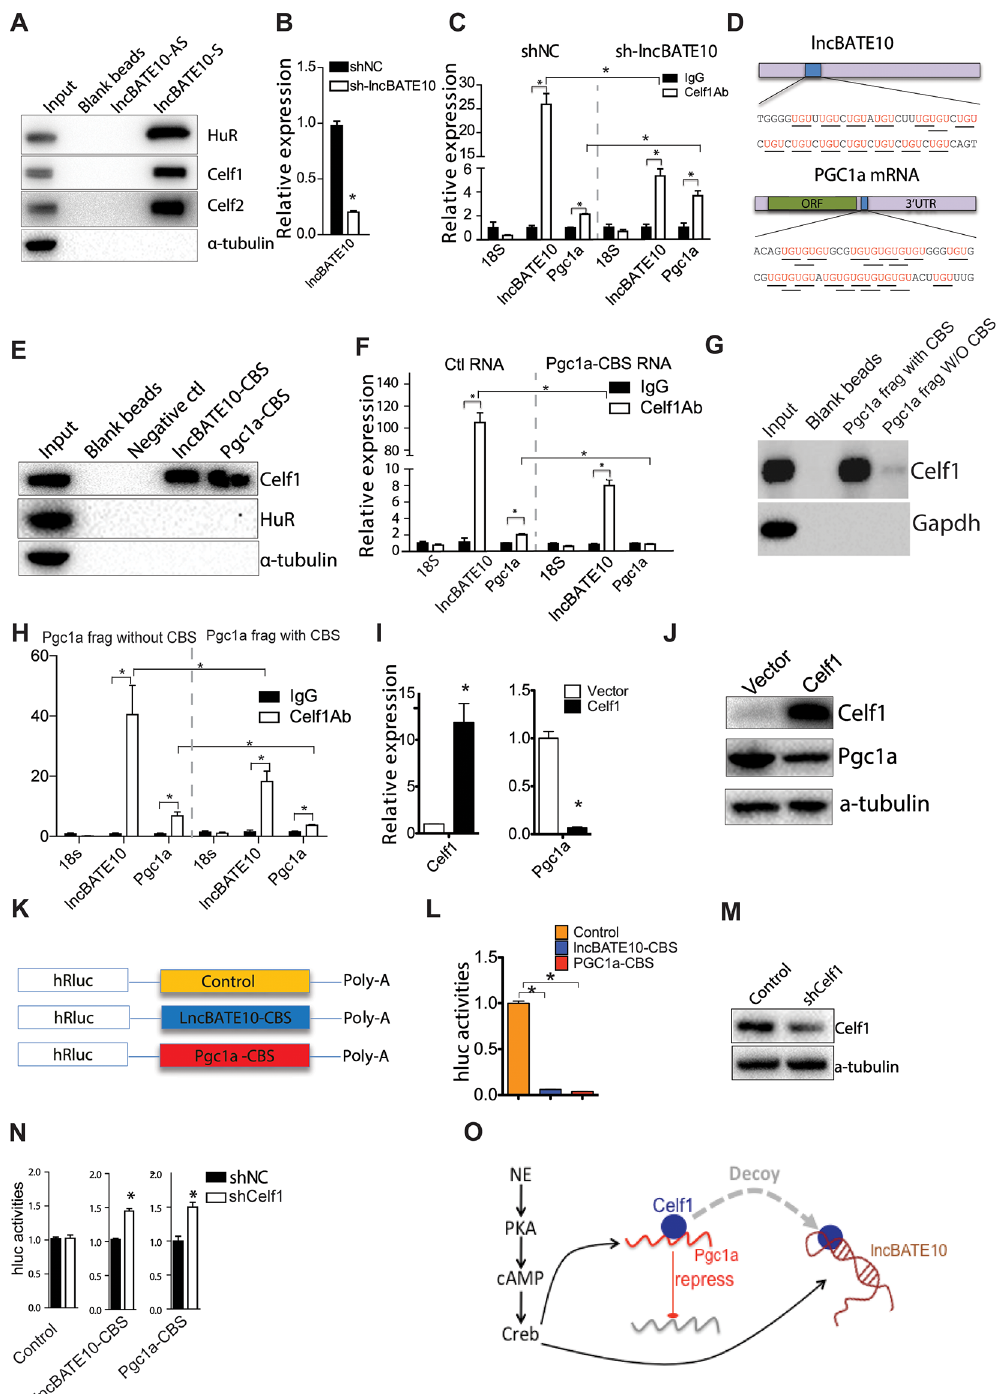
Fig 6. Brown adipose tissue–enriched lncRNA 10 (lncBATE10) decoys CUGBP Elav-Like Family Member 1 (Celf1) from Pgc1 α mRNA. (A) Western blots to detect HuR, Celf1, Celf2 in the RNA-pulldown assay. (B) We used retrovirus to knock down lncBATE10 in primary brown adipocytes.Expression of lncBATE10 were examinedby real-time PCR. (C) We performed RNA immunoprecipitation(RIP) using Celf1-specific antibody in the control and lncBATE10 knockdown cell lysates, and examinedlncBATE10 and Pgc1 α mRNA bindingto Celf1. Error bars are mean ± SEM, n = 3, * P < 0.05 (1-way ANOVA) (D) An illustrationof predicted Celf1 protein bindingsequence(CBS) within lncBATE10 and Pgc1 α mRNA. (E) Western blot to examineCelf1 protein bindingto CBS RNA fragments. The RNA-pulldown assay was carried out using short CBS RNA fragmentsderived from lncBATE10 and Pgc1